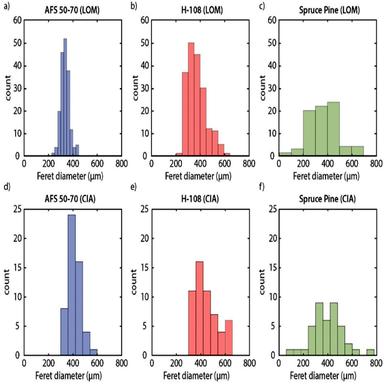
Comparison of size distributions of three different sands by LOM (a–c) and by CIA (d–f).